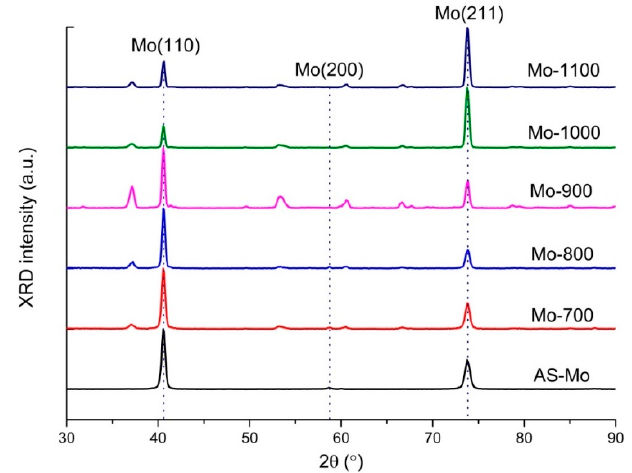
Figure 4. X-ray diffraction (XRD) patterns of Mo thin films, as a function of annealing temperature. Mo Bragg peaks originating from (110), (200), and (211) planes are labelled with dotted lines for guides to the eye. Other unlabeled peaks are associated with Mo oxides phases.